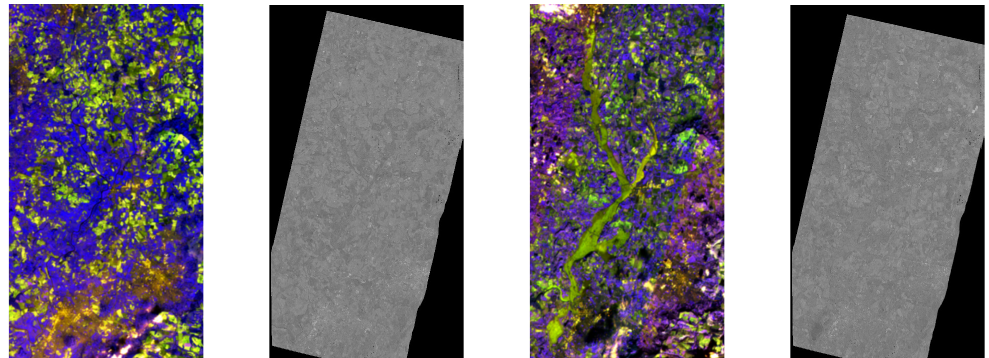
Figure 1. Multi-modal and multi-temporal Images taken in Gloucester, UK. Spot-5 images are displayed using Green, Red and NiR